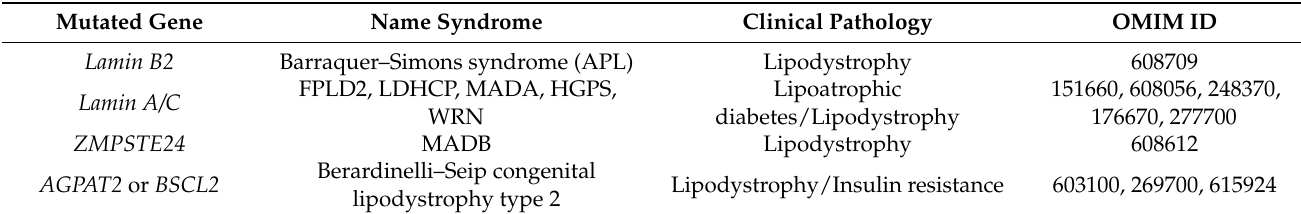
Table 1. Syndromes associated with lipodystrophy, which is a common pathology in envelopathy patients. Online Mendelian Inheritance in Man ( OMIM ) ID is given to refer to the catalogue of genetic